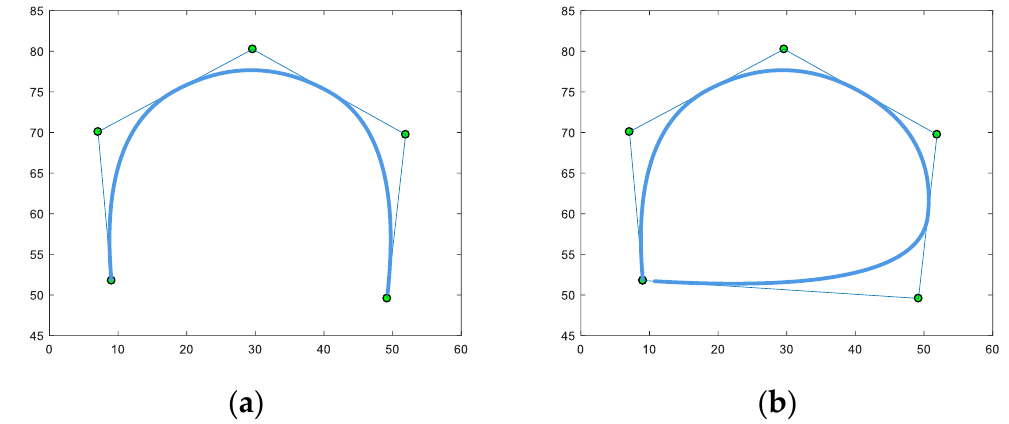
Figure 4. This is a representation of B-spline: ( a ) open spline; ( b ) closed spline.